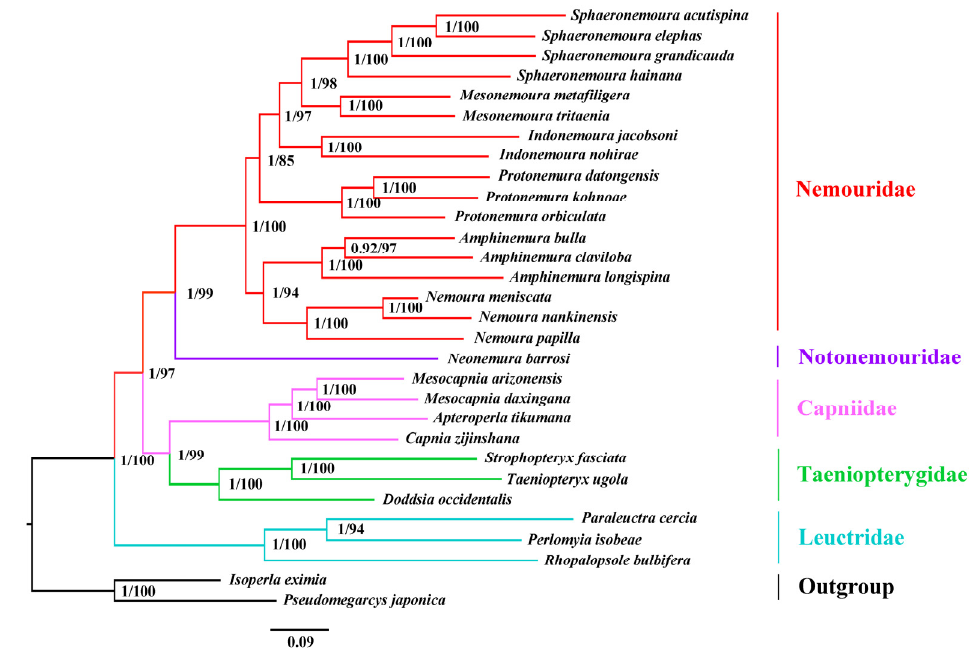
Figure 6. Phylogenetic tree inferred from the sequences of 13 PCGs plus two rRNAs of the mito- chondrial genomes of 28 Nemouroidea species and two outgroups. Numbers at nodes are Bayesian posterior probabilities (left) and ML bootstrap values (right).